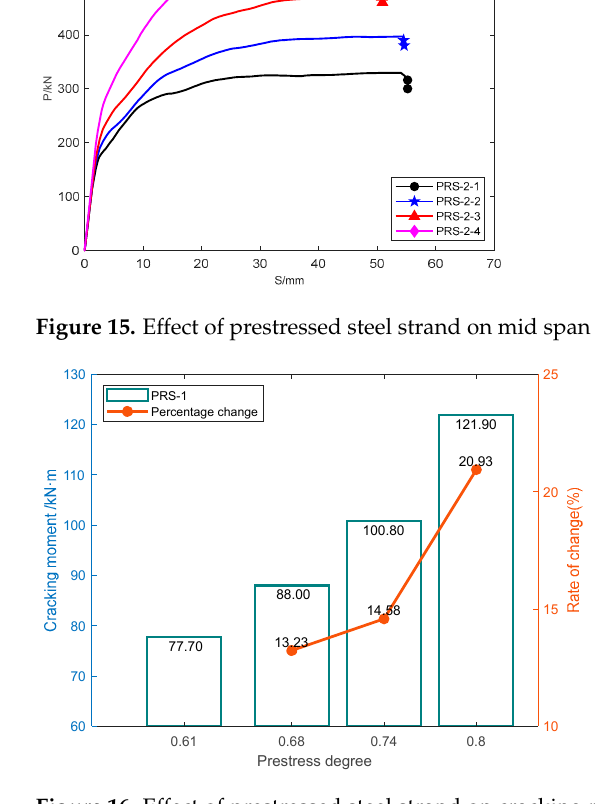
Figure 16. Effect of prestressed steel strand on cracking